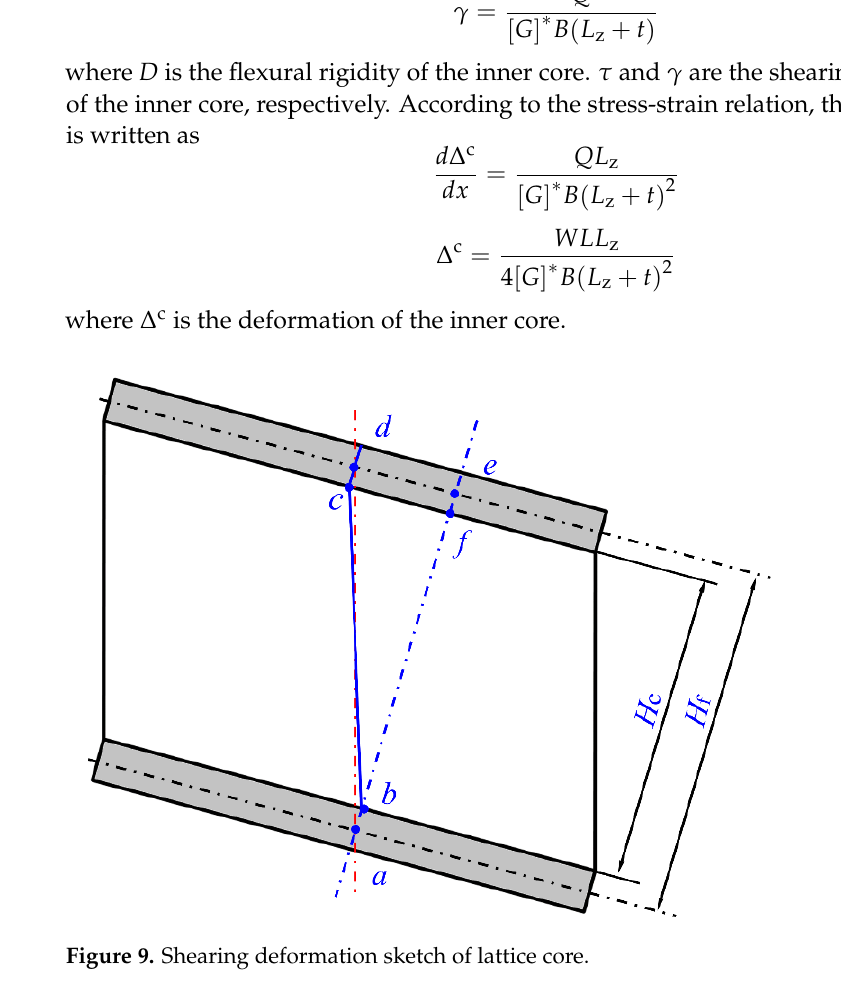
Figure 10. Sketch of the plastic deformation mode for the truss under shearing ( a ) and compressive ( b ) stress. Under shearing force, the rotation angles of the plastic hinge for the truss 1, 3, and 4 are easily calculated by Equations (32) and (33). (